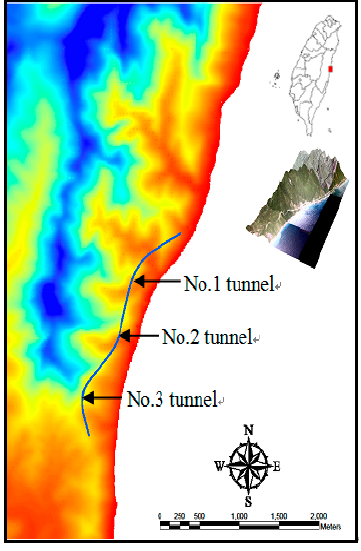
Figure 7. Study area located in the southeast area of Hualien, Taiwan.